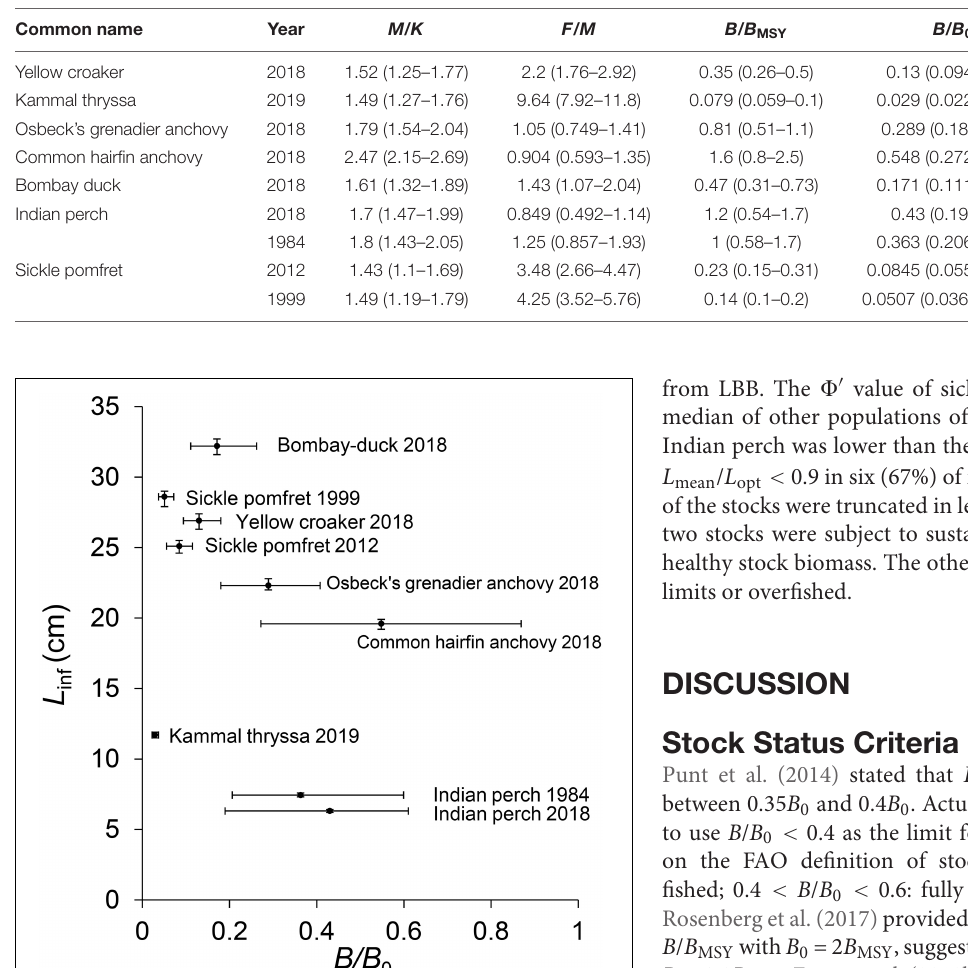
TABLE 2 | Essential reference points from LBB estimates for the fish stocks in question.